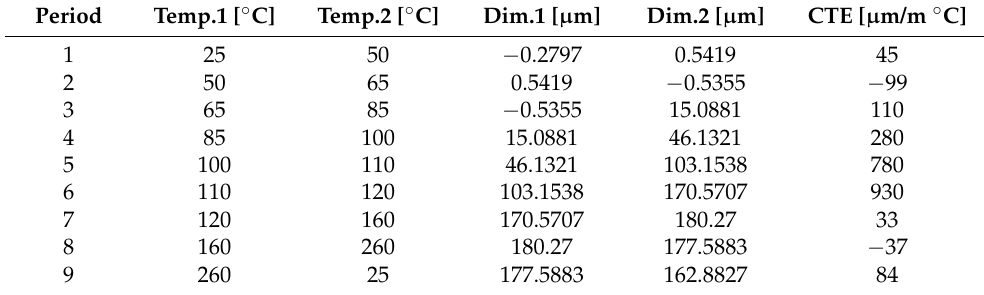
Table 2. CTE of PPG in a y